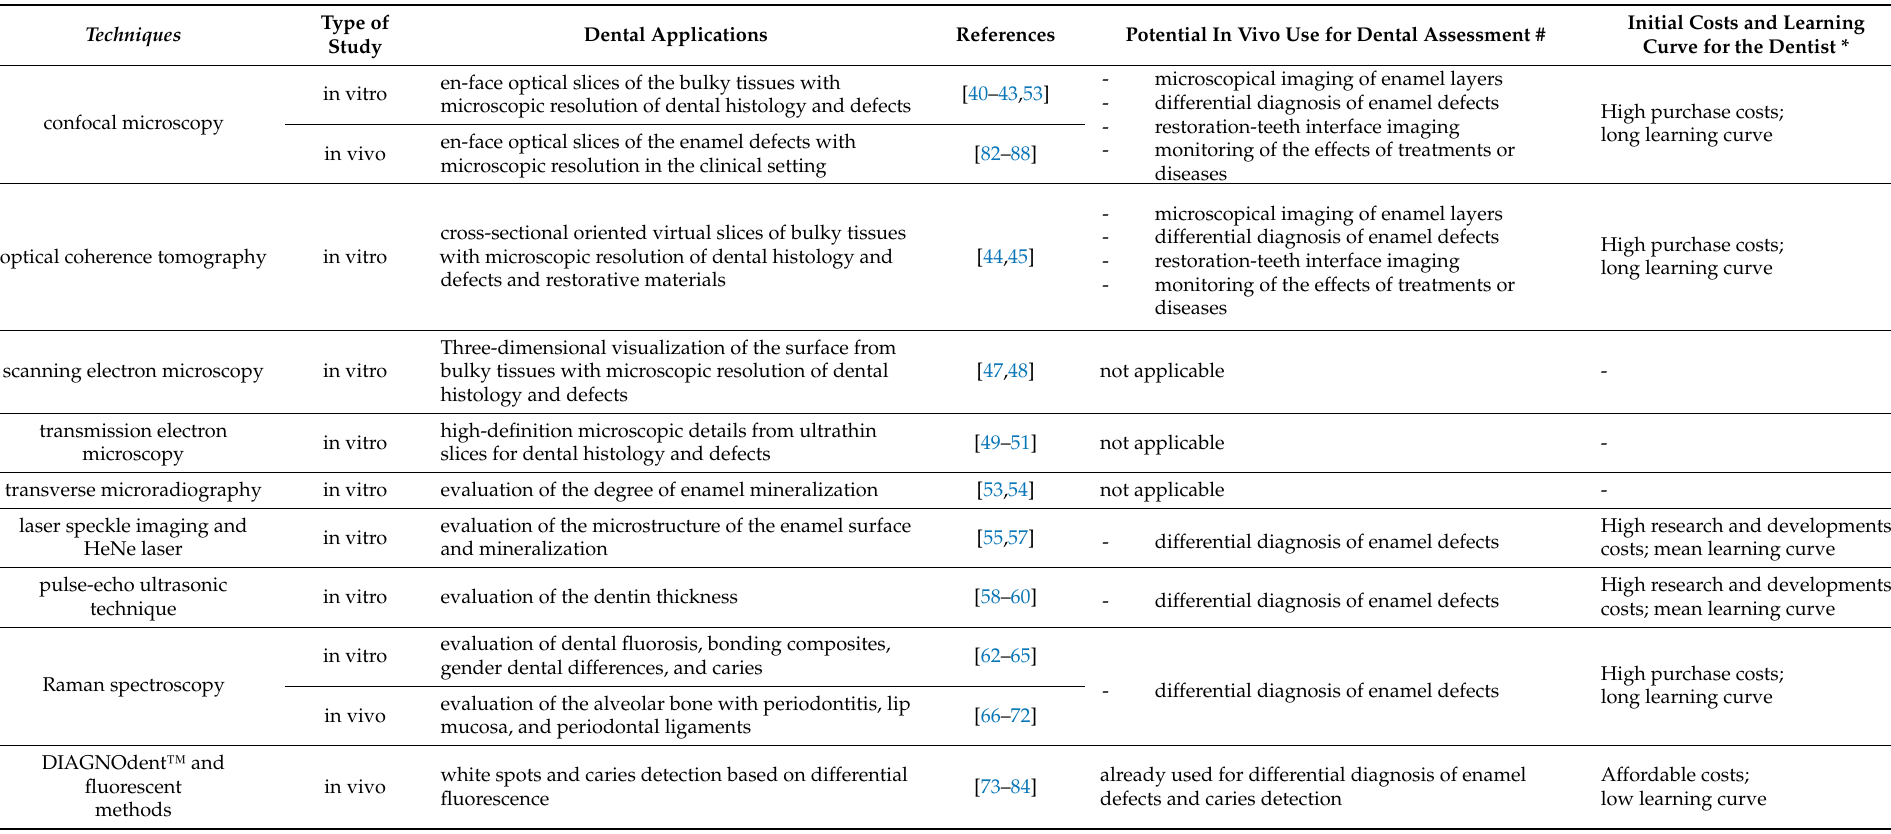
Table 1. Summary characteristics of the included dental imaging